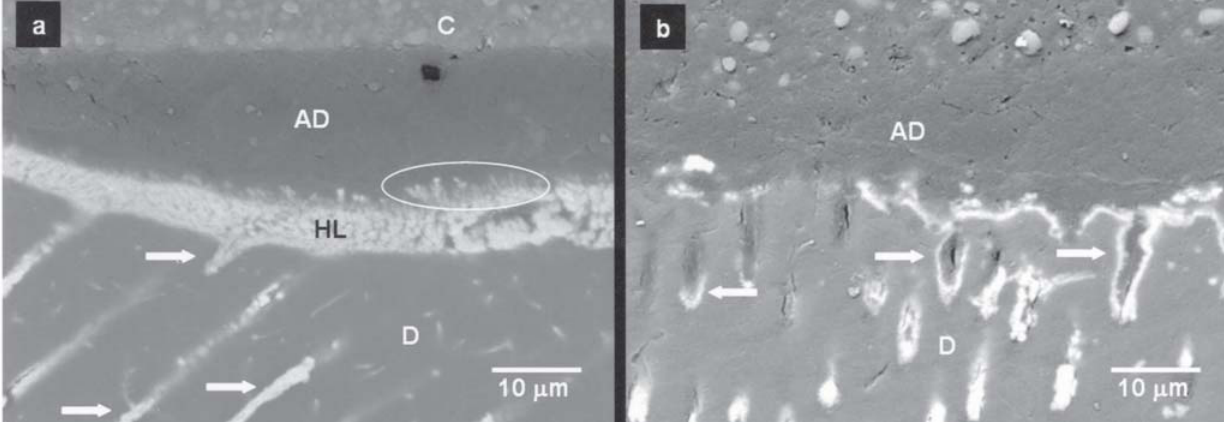
FIGURE 1- Backscattered SEM images of the resin-dentin interface bonded with SBMP (2500x). In (a), acid-etched specimen. Intense silver deposition occurred within the hybrid layer and along the dentin tubules (arrows). Structures suggesting water-tree formation can be seen projecting from hybrid layer to adhesive layer (ellipse). In (b), acid-etched specimen treated with NaOCl. The hybrid layer is not apparent. The nanoleakage pattern showed a thin and discontinuous silver deposition along the resin-dentin interface (ellipsis) and between resin tags and tubule walls (arrows). Amorphous silver structures can be seen within the adhesive layer (pointers). (D) dentin; (C) composite resin; (HL) hybrid layer; (AD) adhesive